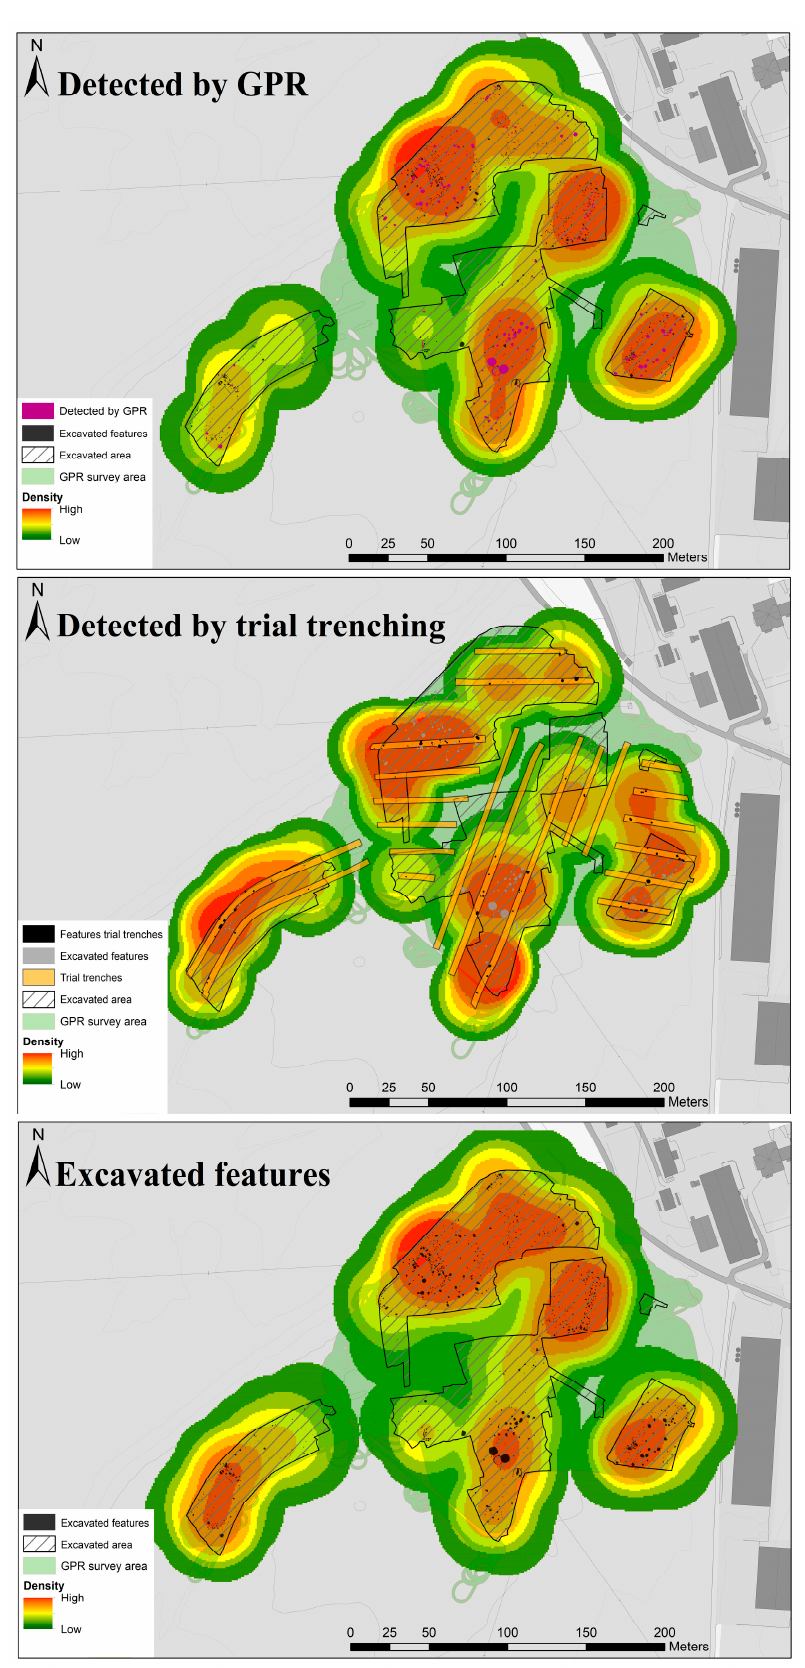
3 Figure 13. Kernel density maps from Øya. Top : GPR, Middle : trial trenching, Bottom : excavation. Map source: The Norwegian Mapping Authority, Geovekst and Municipalities,